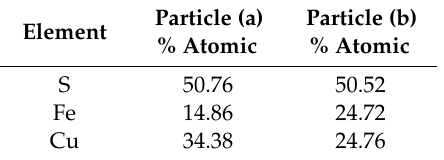
Table 4. Semi-quantitative analysis of Cu-Fe-S phases in copper minerals.